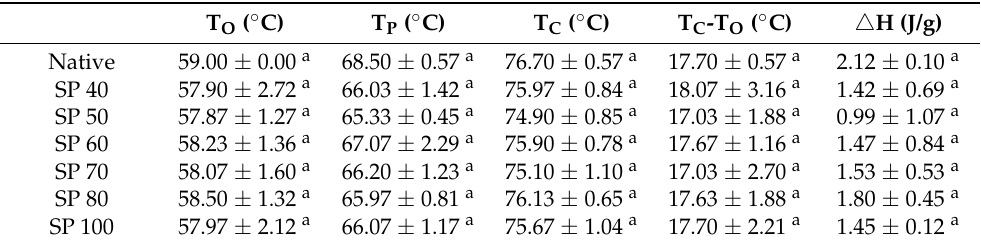
Table 3. DSC thermogram of native and spray dried waxy rice starches. T O , T P , T C , T C -T O and (cid:52) H represents onset, peak, conclusion, difference between conclusion and onset temperature and change in enthalpy. Values denoted with different alphabets in the same column are significantly different ( p <